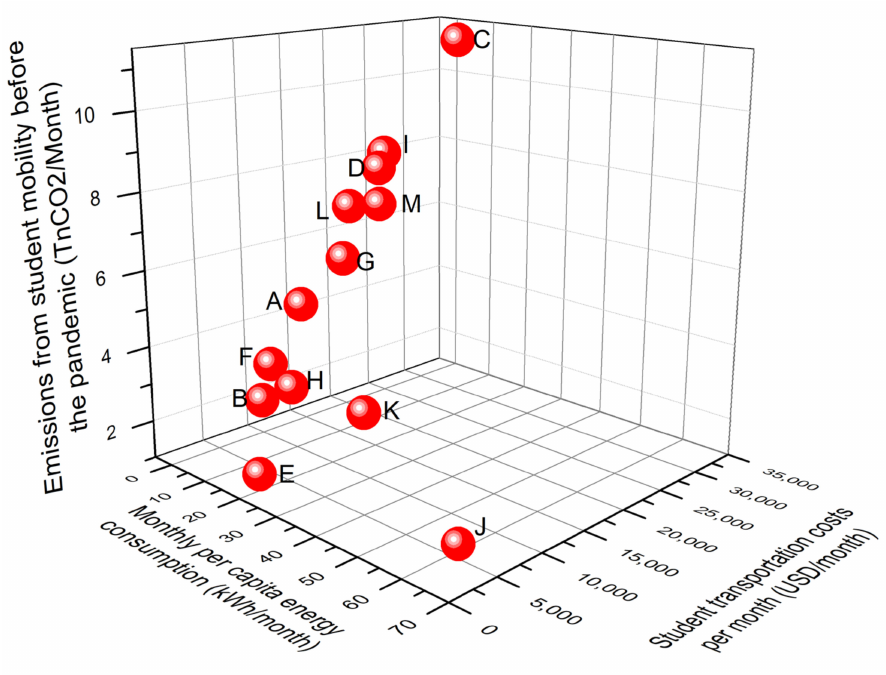
Figure 9. Extrapolated matrix of mobility impacts in 13 universities in Michoac á